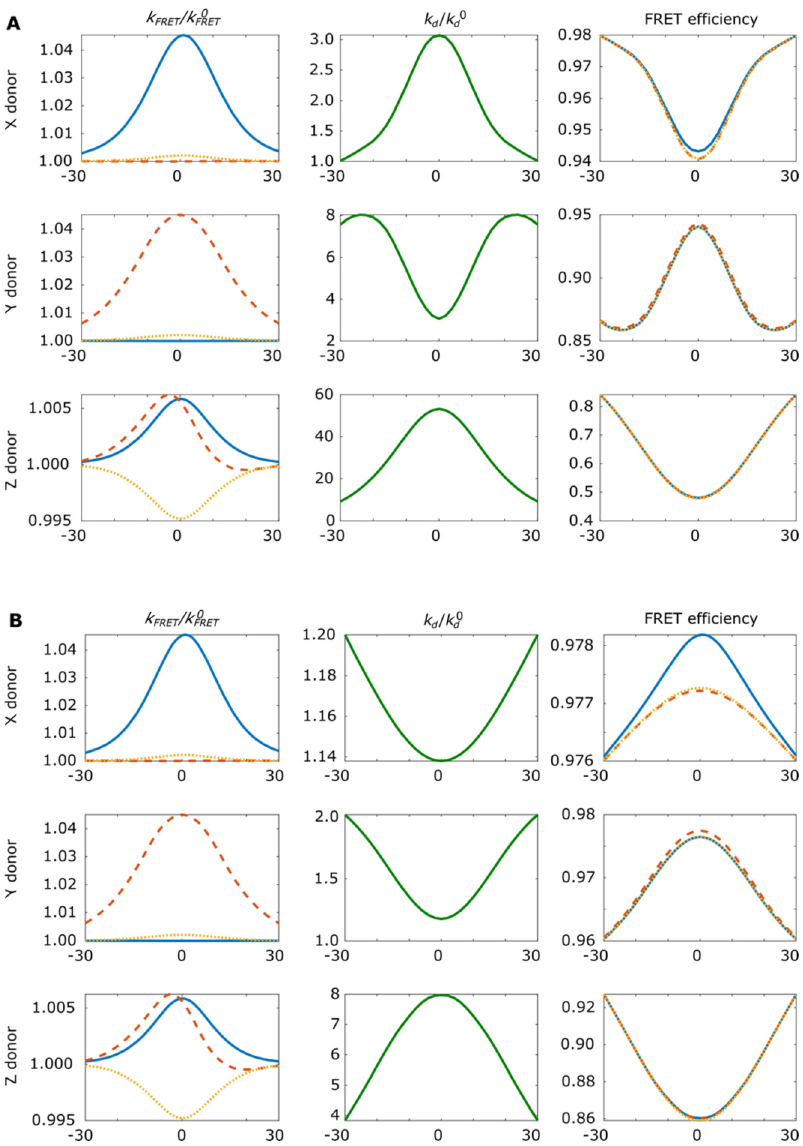
by photonic antennas.